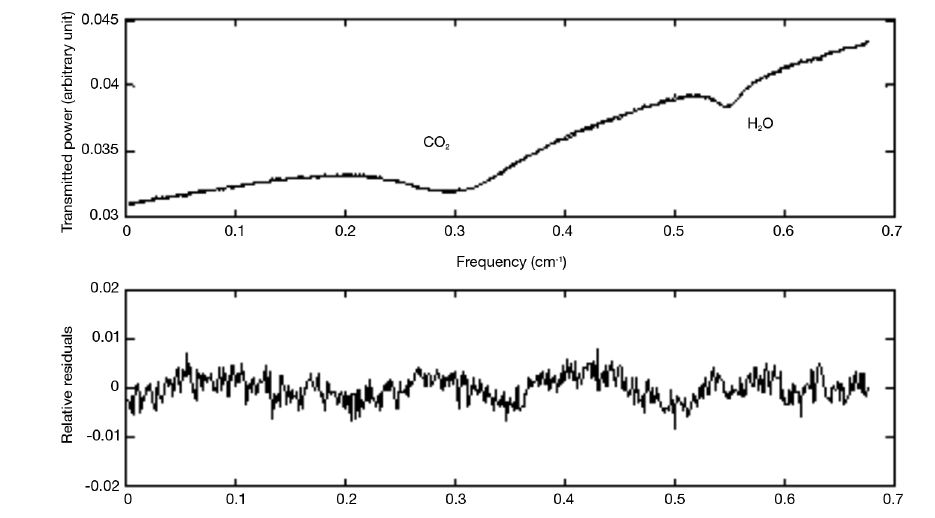
Fig. 2. Direct absorption measurement of CO 2 and H 2 O performed for a small fumarole at the Solfatara vol- cano (Italy). The continuous line represents the Lorentian fit